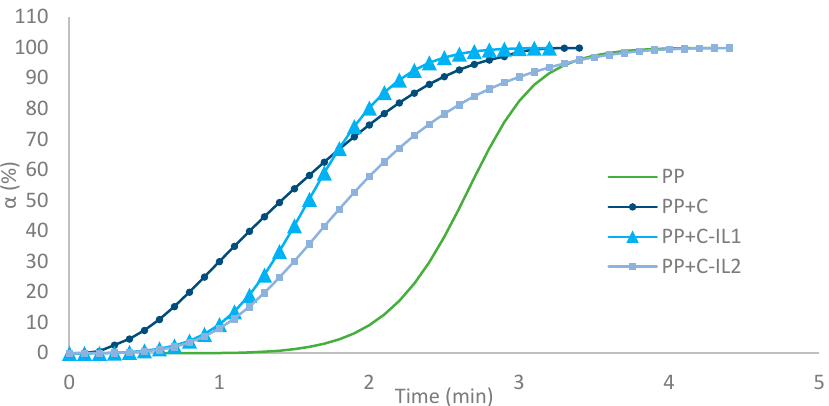
Figure 7. Phase conversion rate of unfilled polypropylene matrix and nanocomposite materials.